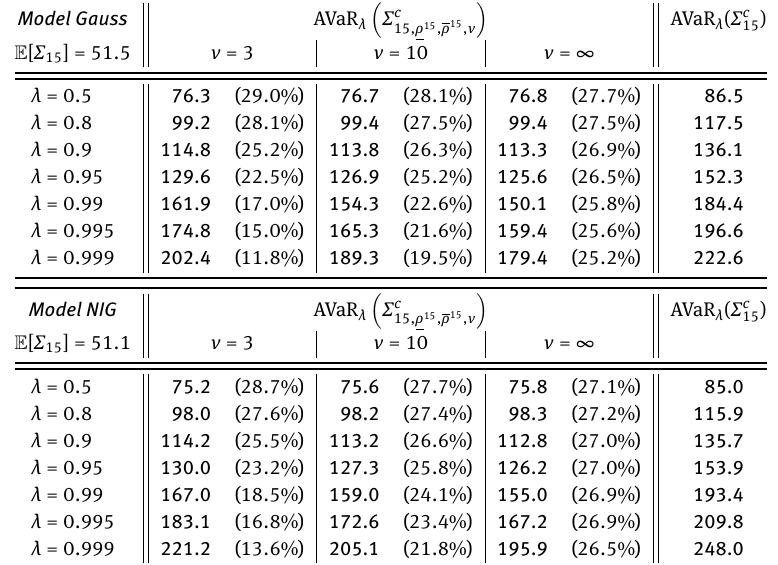
Table 3: Comparison of the improved risk bound AVaR λ ( Σ c AVaR ( Σ 15 ) in Model Gauss resp. NIG for T = 15 trading days for different levels λ , for different ν and for fixed ρ 15 = 0.7767 λ and ρ 15 = −0.5661 . The relative DU-improvement given by 1−(AVaR λ ( Σ c in brackets.